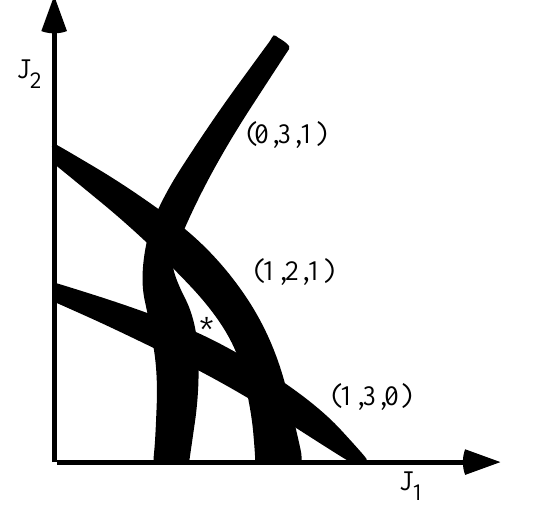
FIG. 1. Resonances of varying width in action space. The asterisk indicates where a KAM surface might